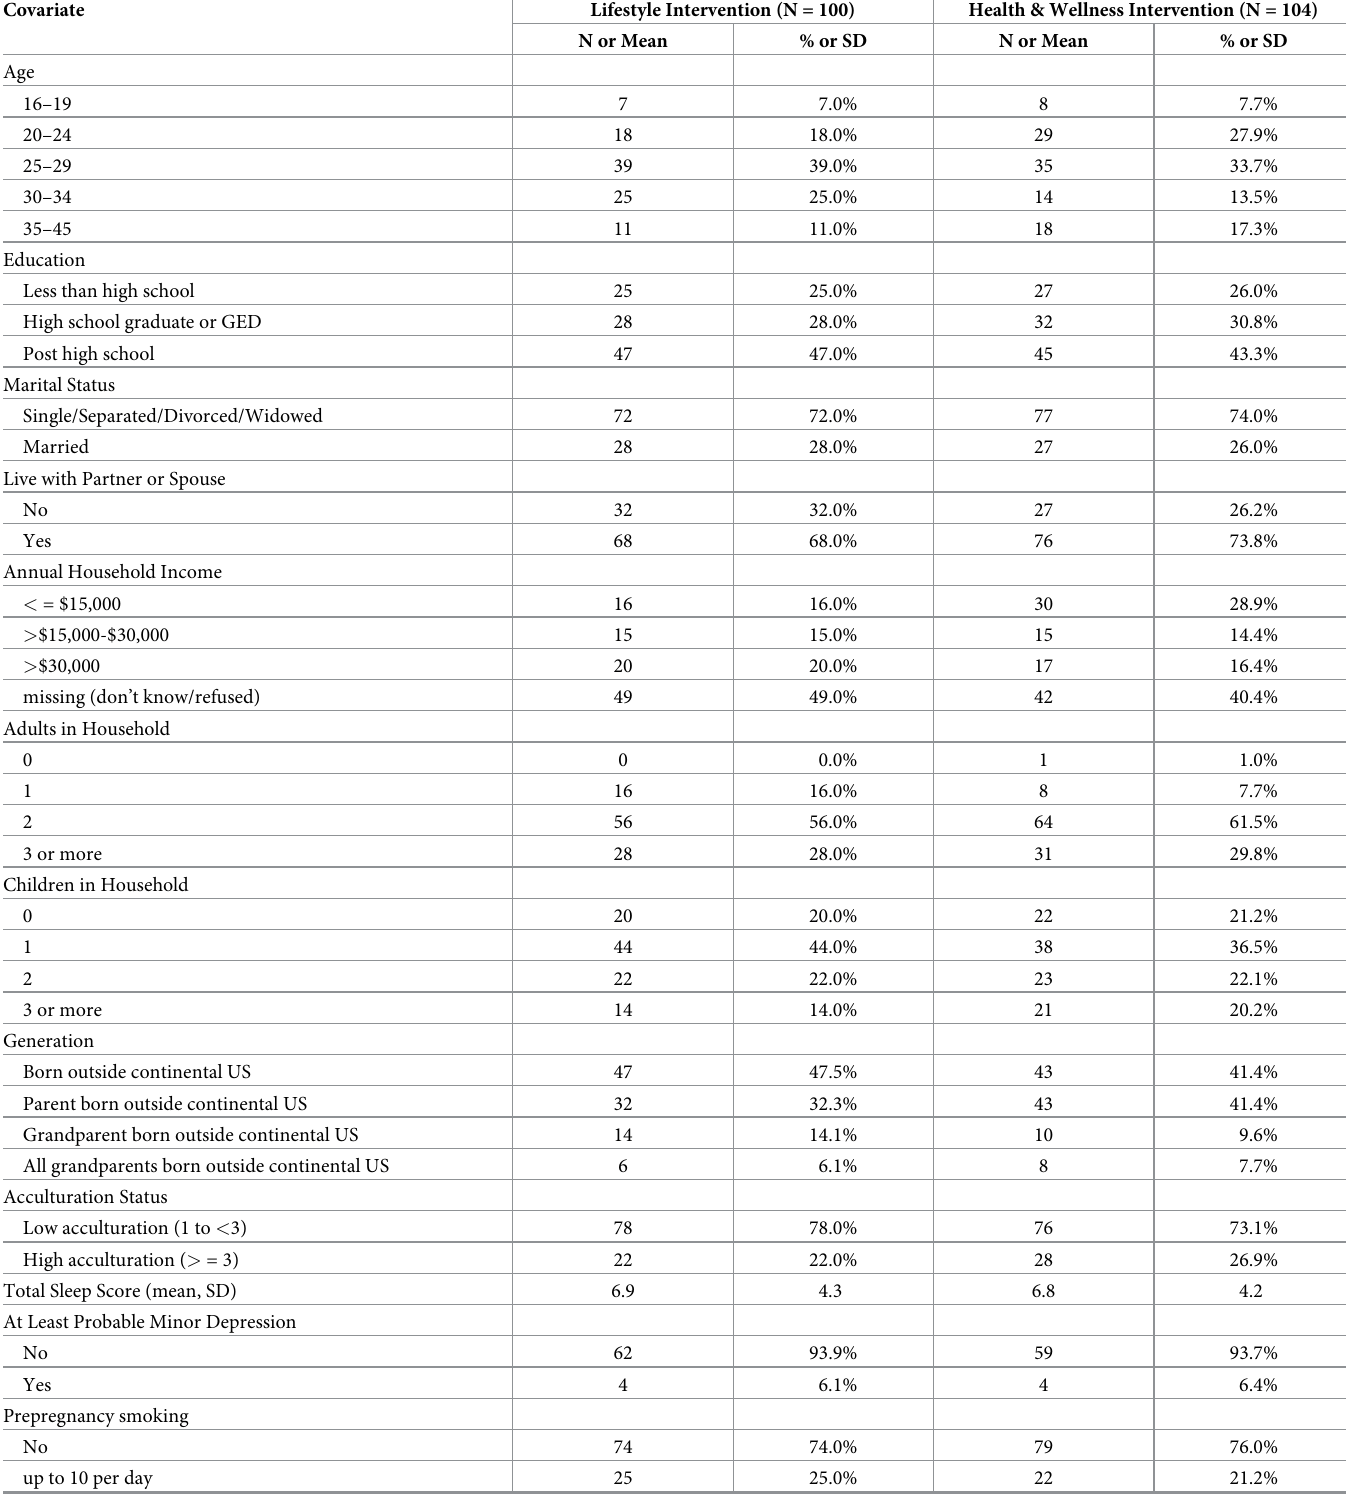
Table 1. Distribution of covariates according to intervention arm; Estudio PARTO 2013–2017.